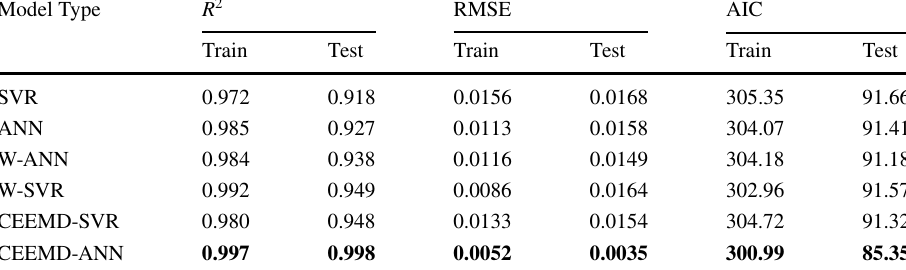
Bold values represent the